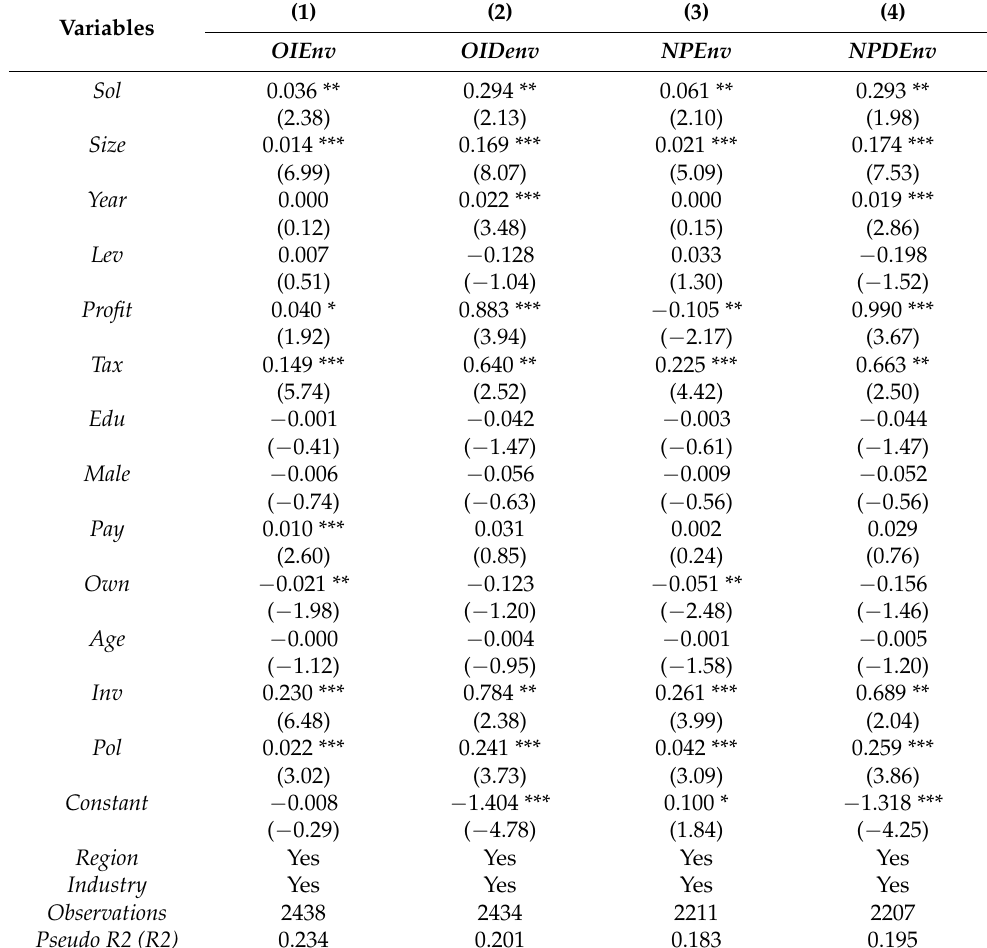
Table 5. Robustness checks of replacing the dependent